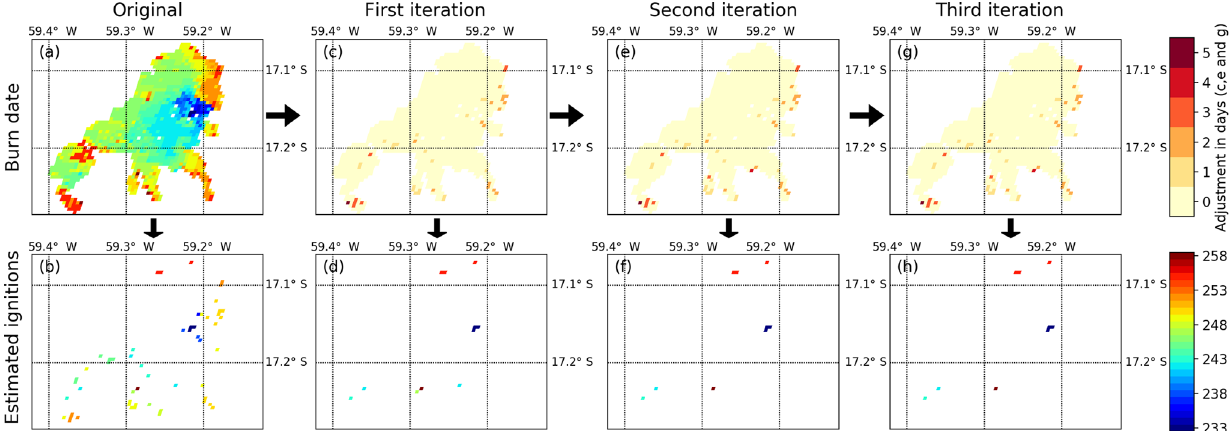
Figure A1. Burn date adjustment to remove local minima that are not associated with ignition points. (a) MCD64A1 burn date estimate for the 2015 example fires in the Brazilian Cerrado ecosystem; (b) local minima within (a) . (c) Burn date adjustment after the first iteration of the ignition point filter and (d) resulting local minima. (e) Burn date adjustment after the second iteration and (f) resulting local minima. (g) Burn date adjustment after the third iteration and (h) resulting local minima. Note that for these particular fires there was no difference between (e, f) and (g, h) , and the final iteration has no added value here. We found that multiple iterations were particularly beneficial for slow-moving fires in forested